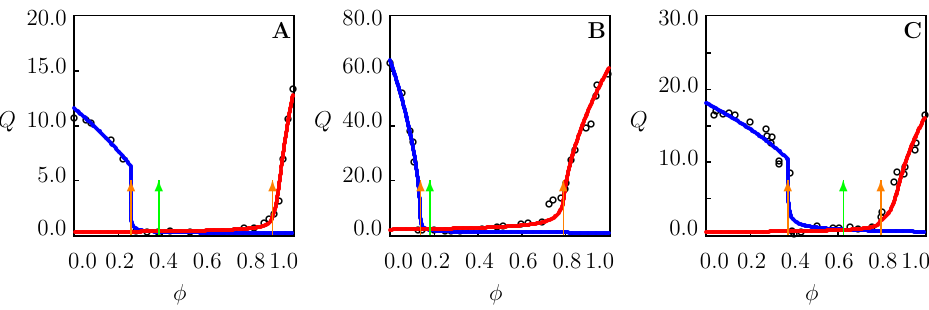
Figure 8. Equilibrium degree of swelling Q versus volume fraction of cosolvent. Circles: experimental data in swelling tests at temperature T = 25 ◦ C. Solid lines: results of numerical analysis. Arrows in- dicate the volume phase transition points. ( A )—PNIPAAm gel in water/dioxane mixture [36]. ( B )—PNIPAAm gel in water/DMSO mixture [42]. ( C )—PNIPAAm gel in aqueous solution of PEG-200